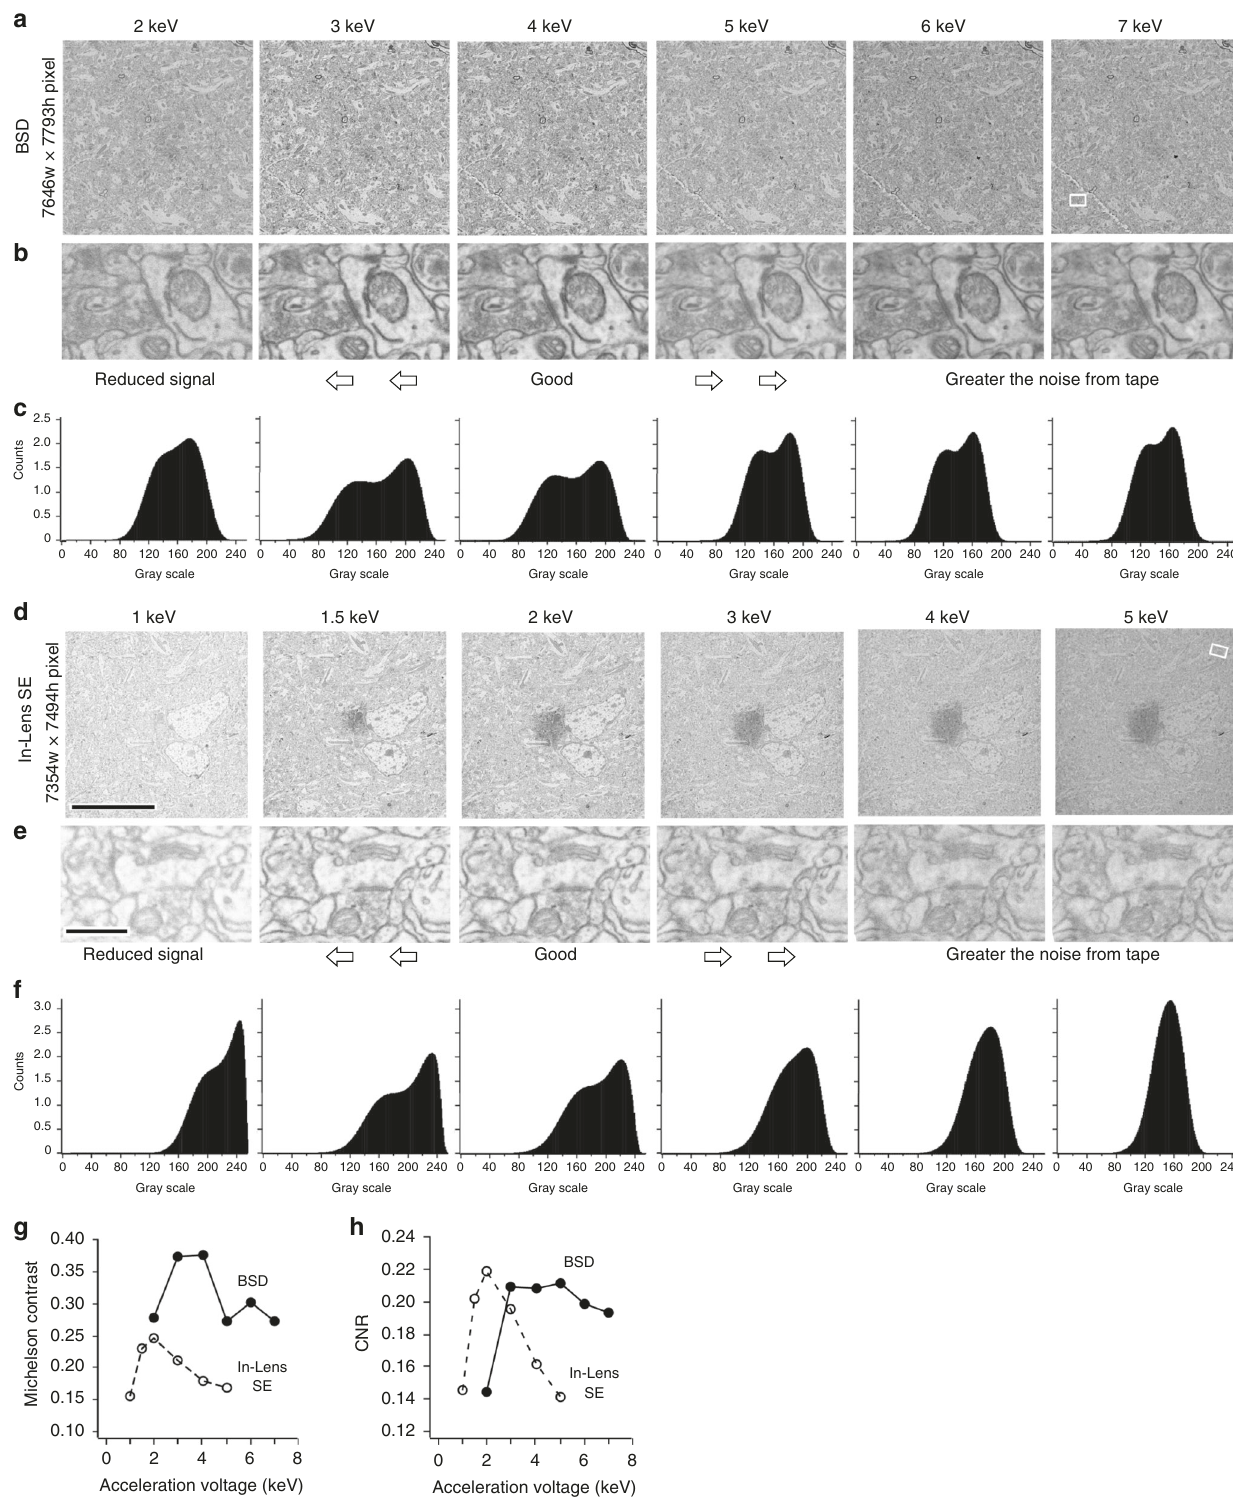
Fig. 6 Image quality varies with different acceleration voltages. a Images of TOLA plus lead section stained brain tissue on the CNT tape are captured with a BSD for 3 nm pixel − 1 , 7646× 7793 pixel image size, 3.2 µ s dwell time, 60 µ m aperture, with different acceleration voltage strengths (2 – 7 keV) with optimized working distance (7.6 mm: 6 keV, 7.7 mm: 5 keV and 4 keV, 7.8 mm: 3 keV, 7.9 mm: 2 keV). b Enlarged images of each acceleration voltage showing a synapse located in the rectangle in right panel of a . c Intensity histogram of the image in a . d Images of the same brain tissue section are captured with an In-lens SE detector for 3 nm pixel − 1 , 7354 × 7494 pixels image, 20 µ m aperture, with different acceleration voltage strengths (1 – 5 keV) with optimized working distance (4.0 mm: 4 – 6 keV, 4.1 mm: 1 – 3 keV) on the CNT tape. Scale, 10 µ m, is also for a . e Enlarged images of each acceleration voltage showing a synapse located in the rectangle in right panel of d . Scale, 0.5 µ m, is also for b . f Intensity histogram of the image in d . g Michelson contrast values at half width of the intensity histogram. h Contrast-to-noise ratio (CNR) extracted from the intensity